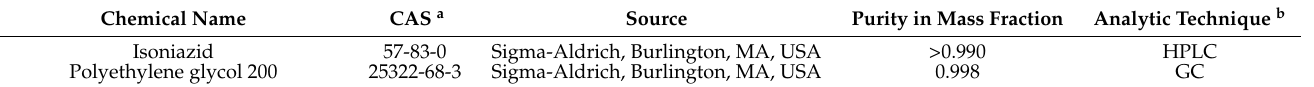
Table 9. Source and purities of the compounds used in this